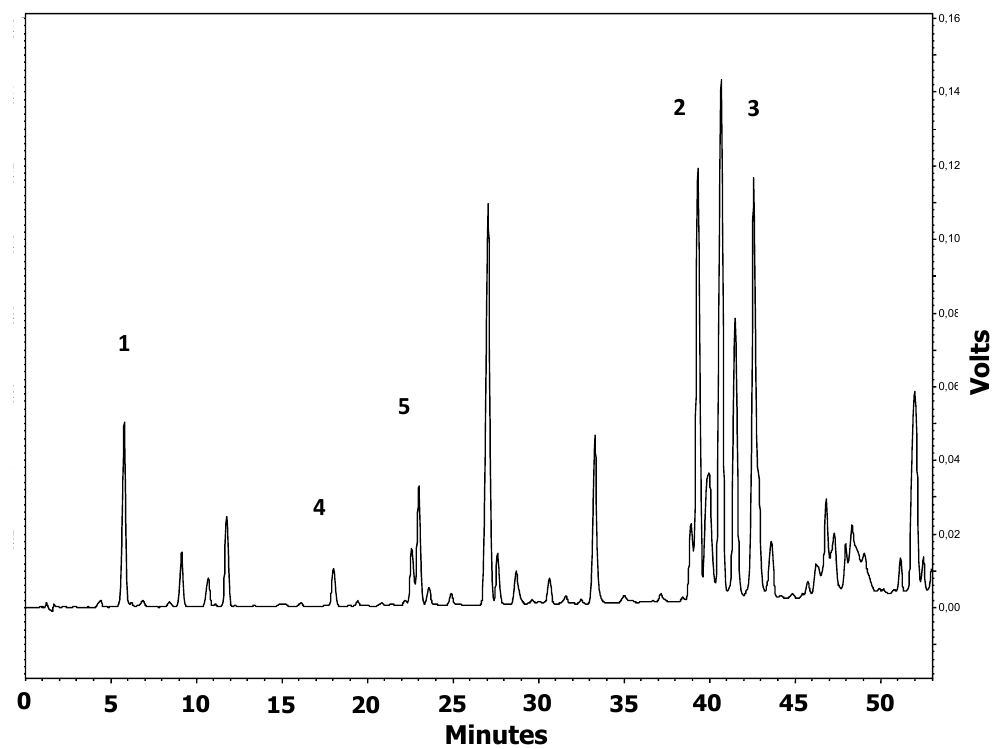
Figure 2. Chromatogram of ethanol extract of propolis used in the study monitored at 290 nm. Peaks are identified as: 1: caffeic acid; 2: chrysin; 3: galangin; 4: quercetin; 5: naringenin.